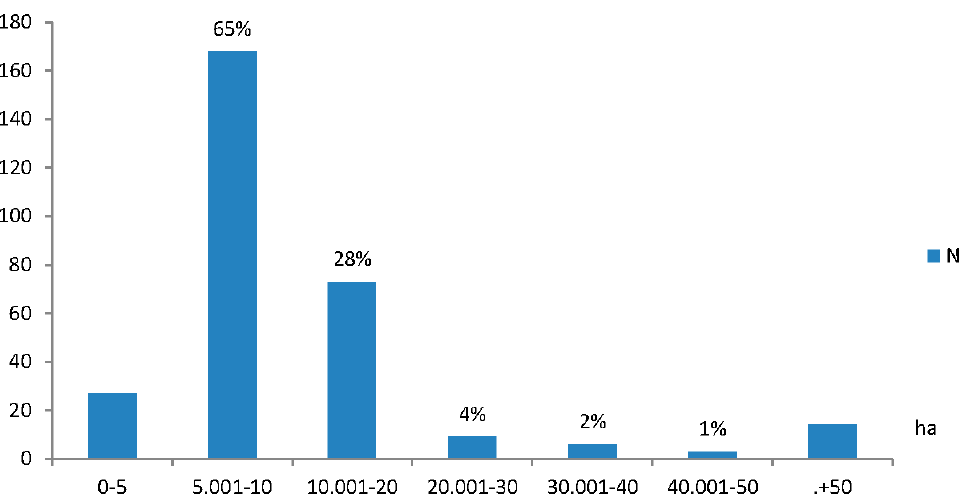
Figure 1. Numbers of medium-scale farmers sampled in Mchinji, Kasungu and Lilongwe, by farm size category (ha) ( N = 300). Source: Authors’ medium-scale farm survey in Mchinji, Kasungu and Lilongwe Districts undertaken by LUANAR, UP, and MSU (2014–2015). Notes: The percentages represent the proportion of farms in each of the categories of medium-scale farmers in the sample ( N = 259). The number of farmers in the different land categories between 5 and 50 ha are significantly different (Anova p -value 2.84 × 10 −88 ).